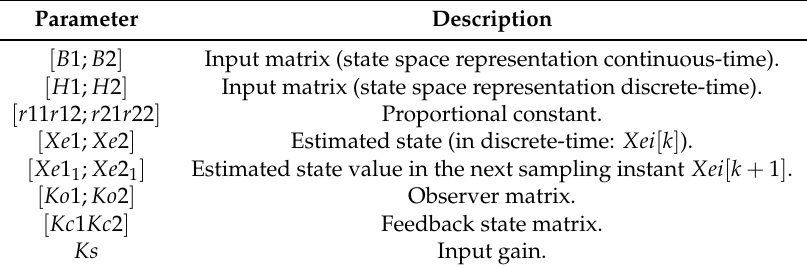
Table A6. Parameters and variables of observer and state feedback control.